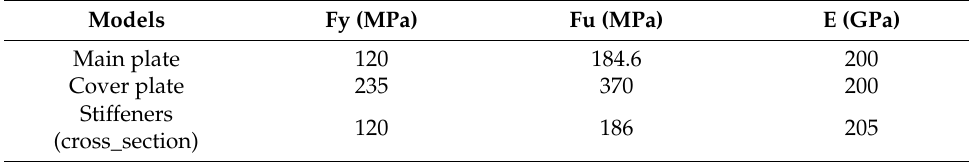
Table 1. The material